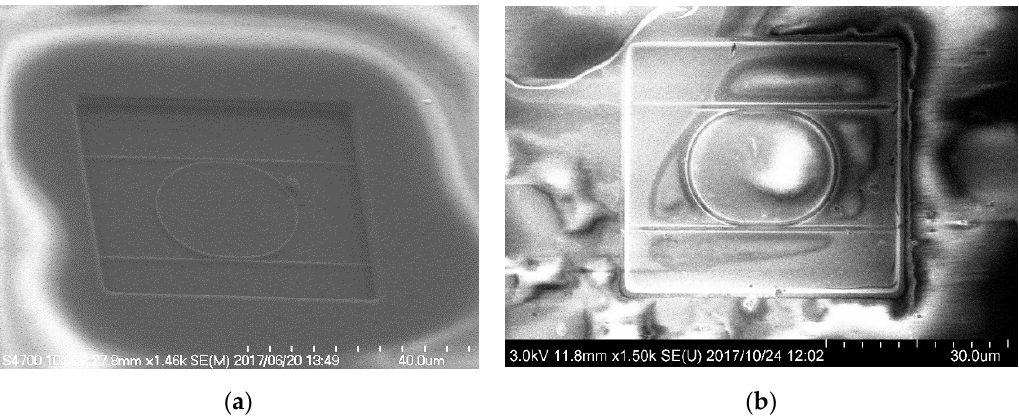
Figure 3. Scanning electron microscopy images of fabricated MRR ( a ) before deposition of Pt-WO 3 /SiO 2 upper cladding layer and ( b ) after deposition of upper WO 3 /SiO 2 layer [30].